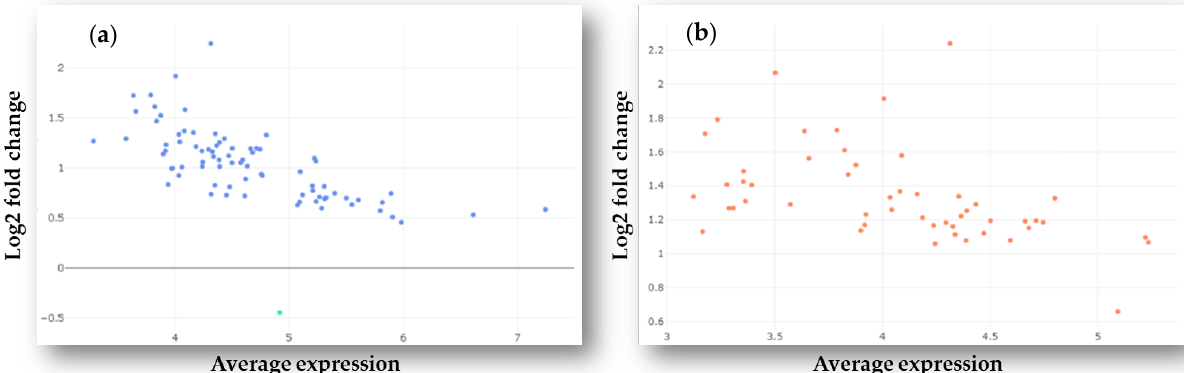
Figure 1. MA plots showing the log 2 fold change of normalized counts in the function of the average expression values of differentially expressed miRNAs in plasma samples of GBM patients. ( a ) Expression data were filtered for false discovery rate (FDR) 0.15 and fold change 0.5; ( b ) The same data were filtered for FDR 0.1 and fold change 1.